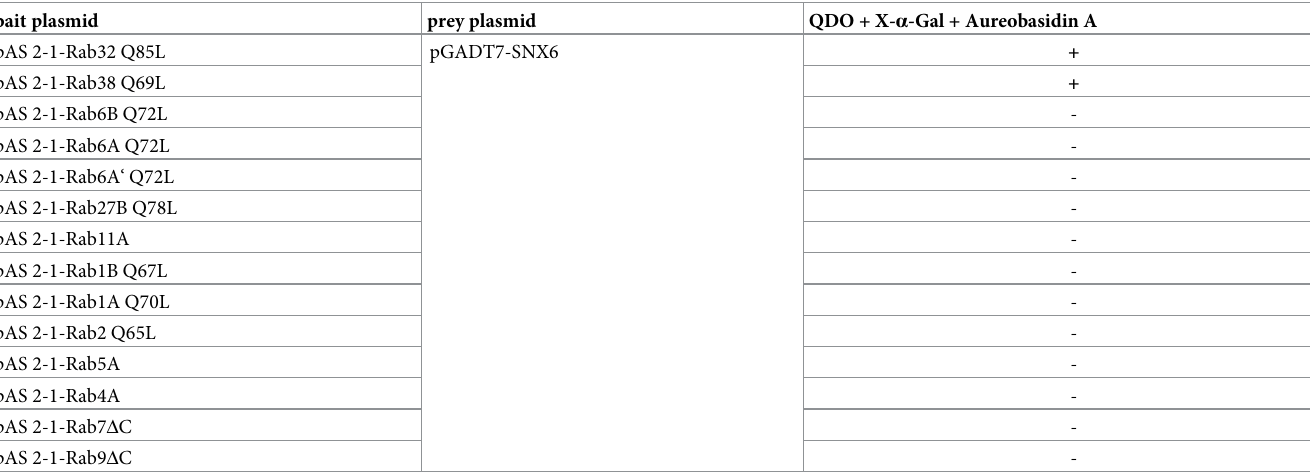
Table 1. Yeast two-hybrid analyses of SNX6 binding to Rab GTPases. bait